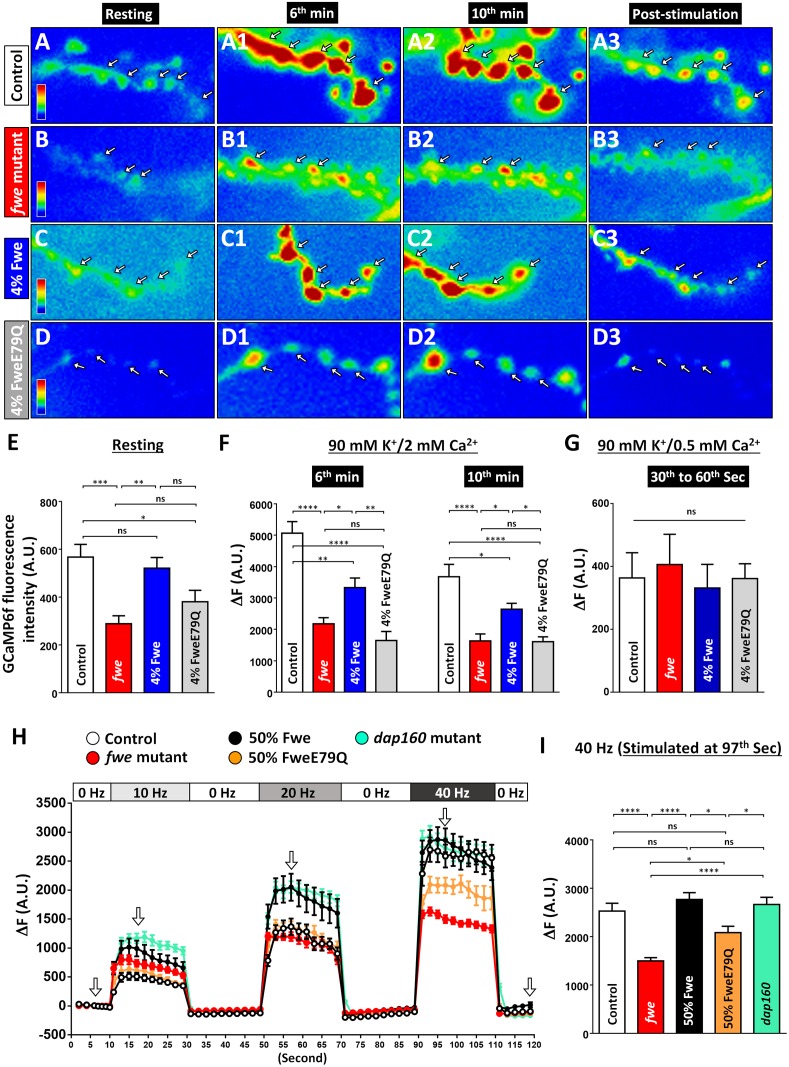
Presynaptic Ca2+ levels are perturbed in fwe mutants upon strong stimulation.(A–E) Pseudocolored GCaMP6f images of neuromuscular junction (NMJ) boutons were obtained from control larvae (vglut-lexA/lexAop2-GCaMP6f, nSyb(w)-GAL4/+ in fweDB25/+, A), fwe mutant larvae (vglut-lexA/lexAop2-GCaMP6f, nSyb(w)-GAL4/+ in fweDB25/fweDB56, B), 4% Fwe-rescued larvae (vglut-lexA/lexAop2-GCaMP6f, nSyb(w)-GAL4/UAS-flag-fwe-RB-HA in fweDB25/fweDB56, C), and 4% FweE79Q-rescued larvae (vglut-lexA/lexAop2-GCaMP6f, nSyb(w)-GAL4/UAS-flag-fweE79Q-RB-HA in fweDB25/fweDB56, D). The vglut-lexA/lexAop2-GCaMP6f larvae expressed detectable amounts of GCaMP6f in boutons when the weak nSyb(w)-GAL4 driver was used to drive expression of UAS-fwe transgenes. Therefore, the use of this binary system allowed us to compare the Ca2+ imaging results between controls, fwe mutants, 4% Fwe-rescued larvae, and 4% FweE79Q-rescued larvae. Boutons were subjected to 10-min 90 mM K+/2 mM Ca2+ stimulation. Representative GCaMP6f images were captured at rest, in the 6th min, in the 10th min, and after stimulation. White arrows indicate type Ib boutons. (E) Data quantifications of the absolute unit (A.U.) of the resting GCaMP6f fluorescence intensity. Loss of fwe impairs the resting Ca2+ levels, which is normalized by expressing 4% Fwe but not 4% FweE79Q. Type Ib boutons of A3 muscles 6/7 were counted, and NMJs (control, n = 13; fwe mutant, n = 16; 4% Fwe, n = 17; and 4% FweE79Q, n = 14) derived from ≥6 larvae for each genotype were analyzed. (F) Data quantifications of the increases in GCaMP6f fluorescence in the 6th or 10th min. The increase in the intracellular Ca2+ level in response to high K+ stimulation is perturbed by loss of fwe. The expression of 4% Fwe but not 4%FweE79Q partially rescues these defects. Type Ib boutons of A3 muscles 6/7 were counted, and NMJs (6th min: control, n = 5; fwe mutant, n = 6; 4% Fwe, n = 8; 4% FweE79Q, n = 6. 10th min: control, n = 7; fwe mutant, n = 6; 4% Fwe, n = 10; and 4% FweE79Q, n = 6) derived from ≥5 larvae for each genotype were analyzed. (G) Larvae of the indicated genotypes were subjected to 1-min 90 mM K+/0.5 mM Ca2+ stimulation. The GCaMP6f images were taken between 30–60 s. The increase in GCaMP6f fluorescence is shown. The Ca2+ increase is similar among all genotypes. Type Ib boutons of A3 muscles 6/7 were counted, and NMJs (control, n = 6; fwe mutant, n = 6; 4% Fwe, n = 6; and 4% FweE79Q, n = 6) derived from 6 larvae for each genotype were analyzed. (H) The time-course traces of the changes in GCaMP6f fluorescence in NMJ boutons in response to electric stimuli. The images were captured from control larvae (nSyb-GAL4/UAS-GCaMP6f in fweDB25/+, white circle), fwe mutant larvae (nSyb-GAL4/UAS-GCaMP6f in fweDB25/fweDB56, red circle), 50% Fwe-rescued larvae (nSyb-GAL4/UAS-GCaMP6f/UAS-flag-fwe-RB-HA in fweDB25/fweDB56, black circle), 50% FweE79Q-rescued larvae (nSyb-GAL4/UAS-GCaMP6f/UAS-flag-fweE79Q-RB-HA in fweDB25/fweDB56, orange circle), and dap160 mutants (nSyb-GAL4/UAS-GCaMP6f in dap160Δ1/dap160Δ2, green circle). Boutons were subjected to train stimulations of 10-, 20-, and 40-Hz-triggered action potentials, with a 20-s rest between train stimuli. White arrows indicate the time points when the representative GCaMP6f images in S5A–S5E Fig were obtained. (I) The average increase in GCaMP6f fluorescence at 97 s is shown. Loss of Fwe or its channel activity does not affect the Ca2+ increases evoked at 10 Hz and 20 Hz but impairs the Ca2+ increases evoked at 40 Hz. Type Ib boutons of A3 muscles 6/7 were counted, and NMJs (control, n = 20; fwe mutant, n = 16; 50% Fwe, n = 14; 50% FweE79Q, n = 12; and dap160 mutant, n = 16) derived from ≥6 larvae for each genotype were analyzed. A one-way ANOVA test was used for statistical analysis. p-Value: ns, not significant; *, p < 0.05; **, p < 0.01; ***, p < 0.01; ****, p < 0.001. Error bars indicate the standard error of the mean. All images were captured in the same scale. The underlying data can be found in S1 Data.